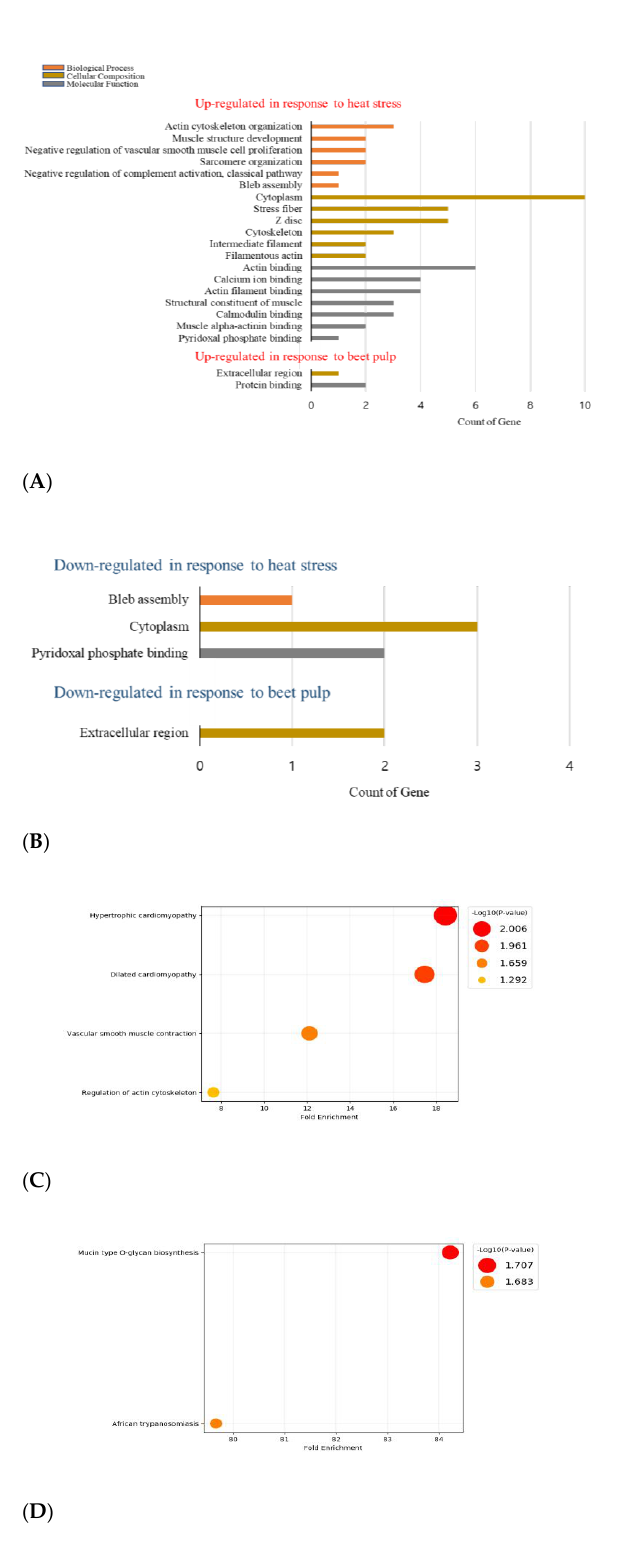
Figure 3. Functional analysis of the DEGs in HS and HS + BP treatments: ( A ) GO classification of the DEGs upregulated; ( B ) GO classification of the DEGs downregulated; ( C ) KEGG pathway enrichment results of the DEGs in HS vs. NT; ( D ) KEGG pathway enrichment results of the DEGs HS + BP vs. HS; The GO analysis was performed under Biological Process, Cellular Composition, and Molecular Functions categories; NT, normal temperature; HS, heat stress; HS + BP, dietary beet pulp under heat